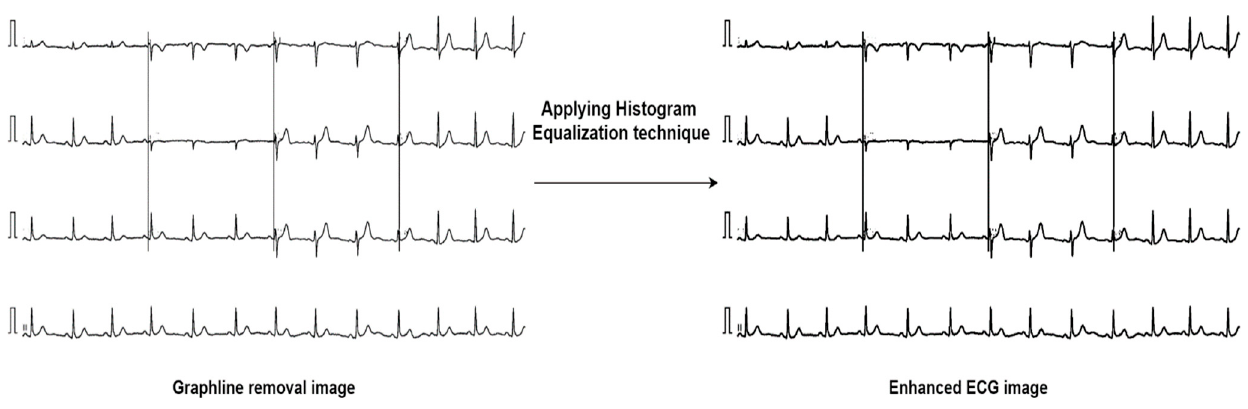
Figure 7. Enhance image quality using HE techniques.